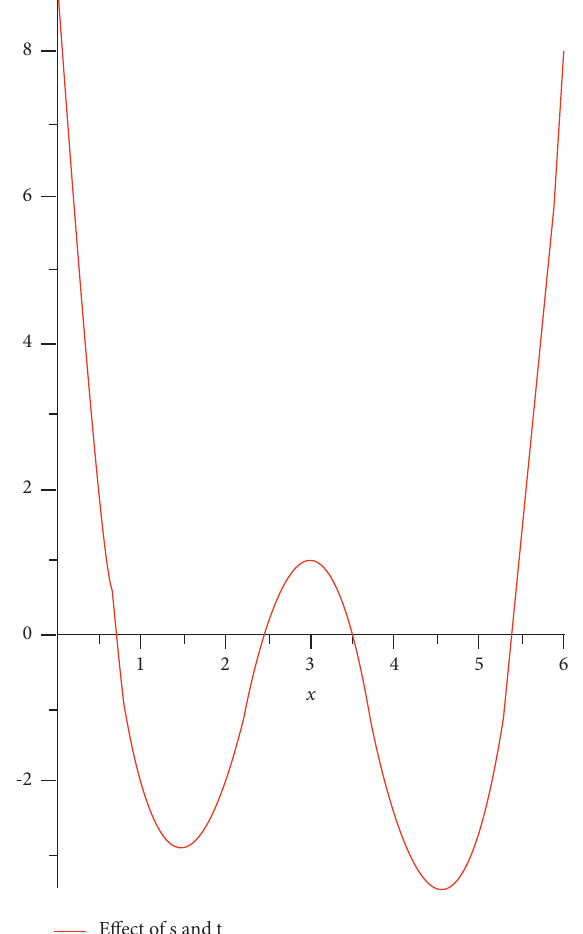
Figure 9: Impact of shape parameters t and as it moves away from connecting